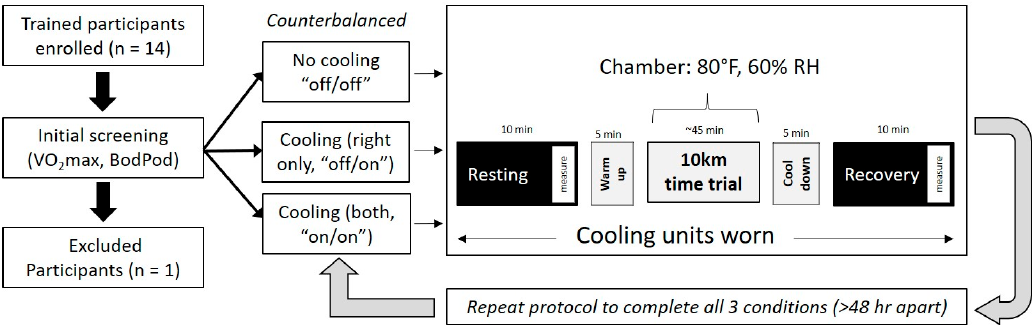
Figure 1. Experimental overview: RMR, resting metabolic rate; IET, incremental exercise test.